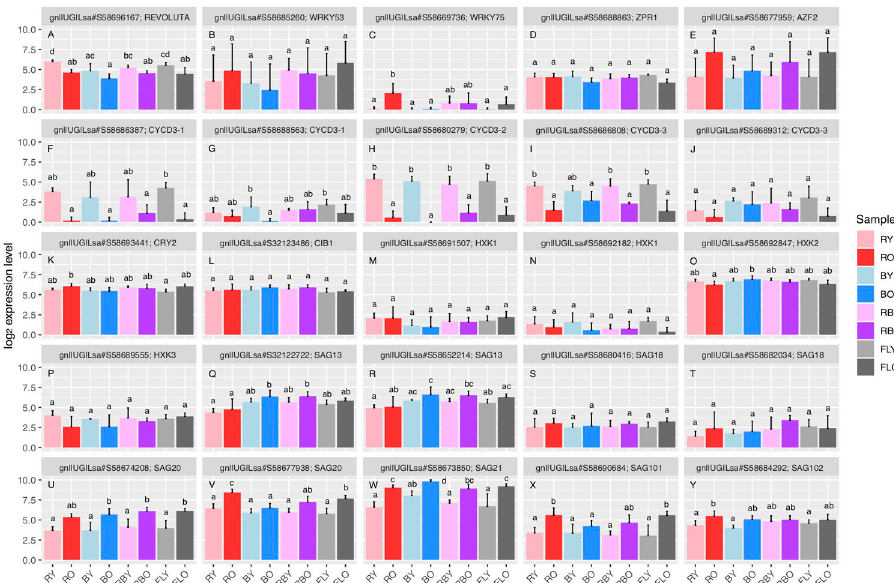
Fig 6. Expression levels of genes involved in leaf senescence. The log 2 gene expression levels for the leaf samples harvested from young (Y) and old (O) leaves of plants grown under the red (R), blue (B), and red/blue (RB) LEDs and the fluorescent (FL) light are presented on the different bars. Mean ± SD values for five replicate samples are shown. Different superscripts on the bars indicate a significant difference (p < 0.05) by ANOVA with Tukey’s HSD test.